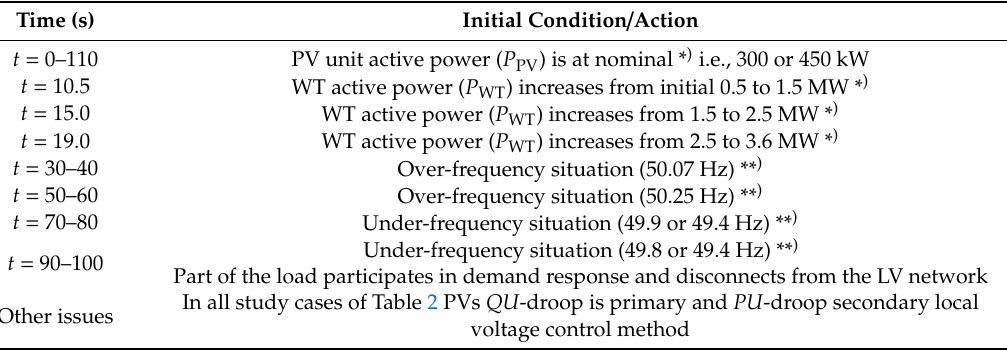
Table 3. Simulation sequence actions and other issues in study cases (see Table 2 and Figure 1). Total simulation time t = 110